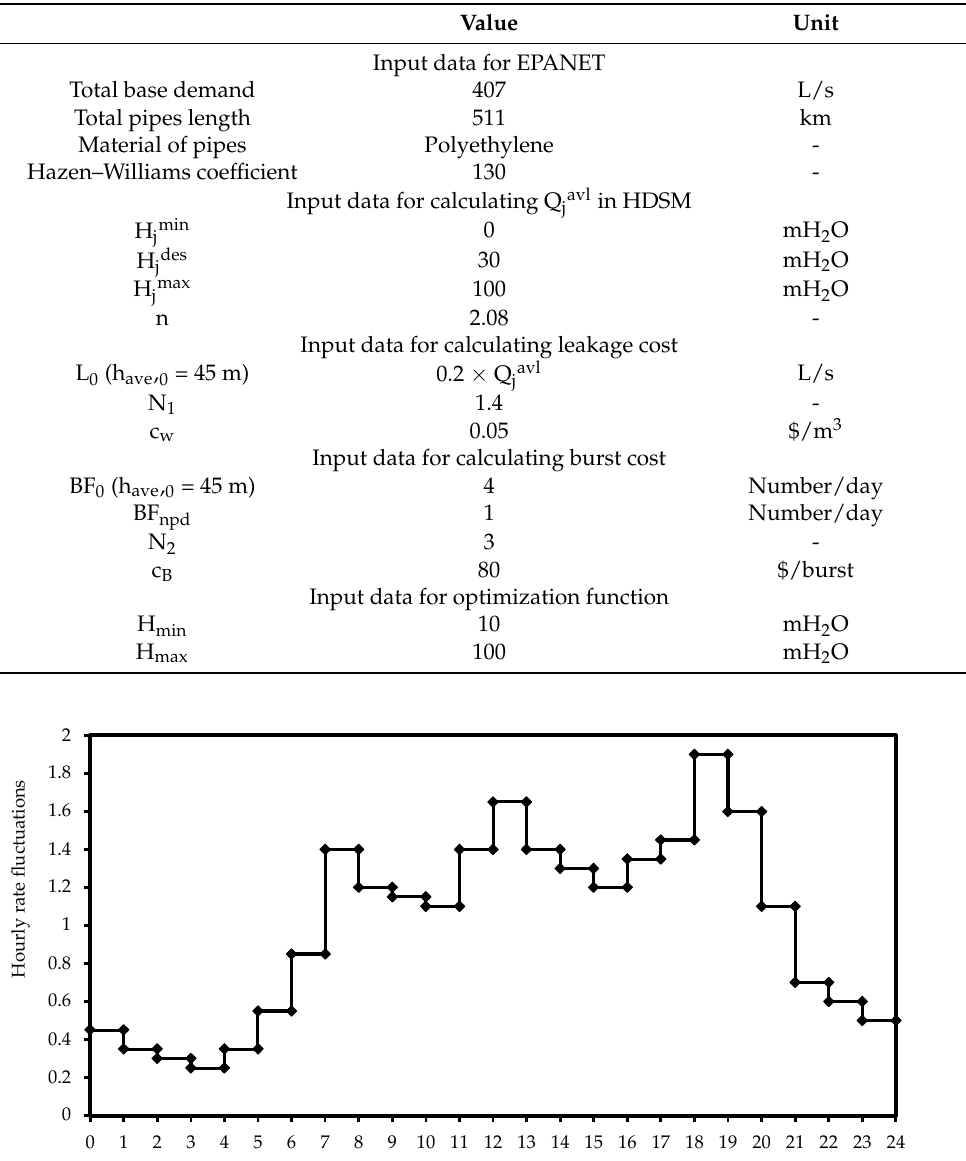
Table 3. Basic information on the water sector model.